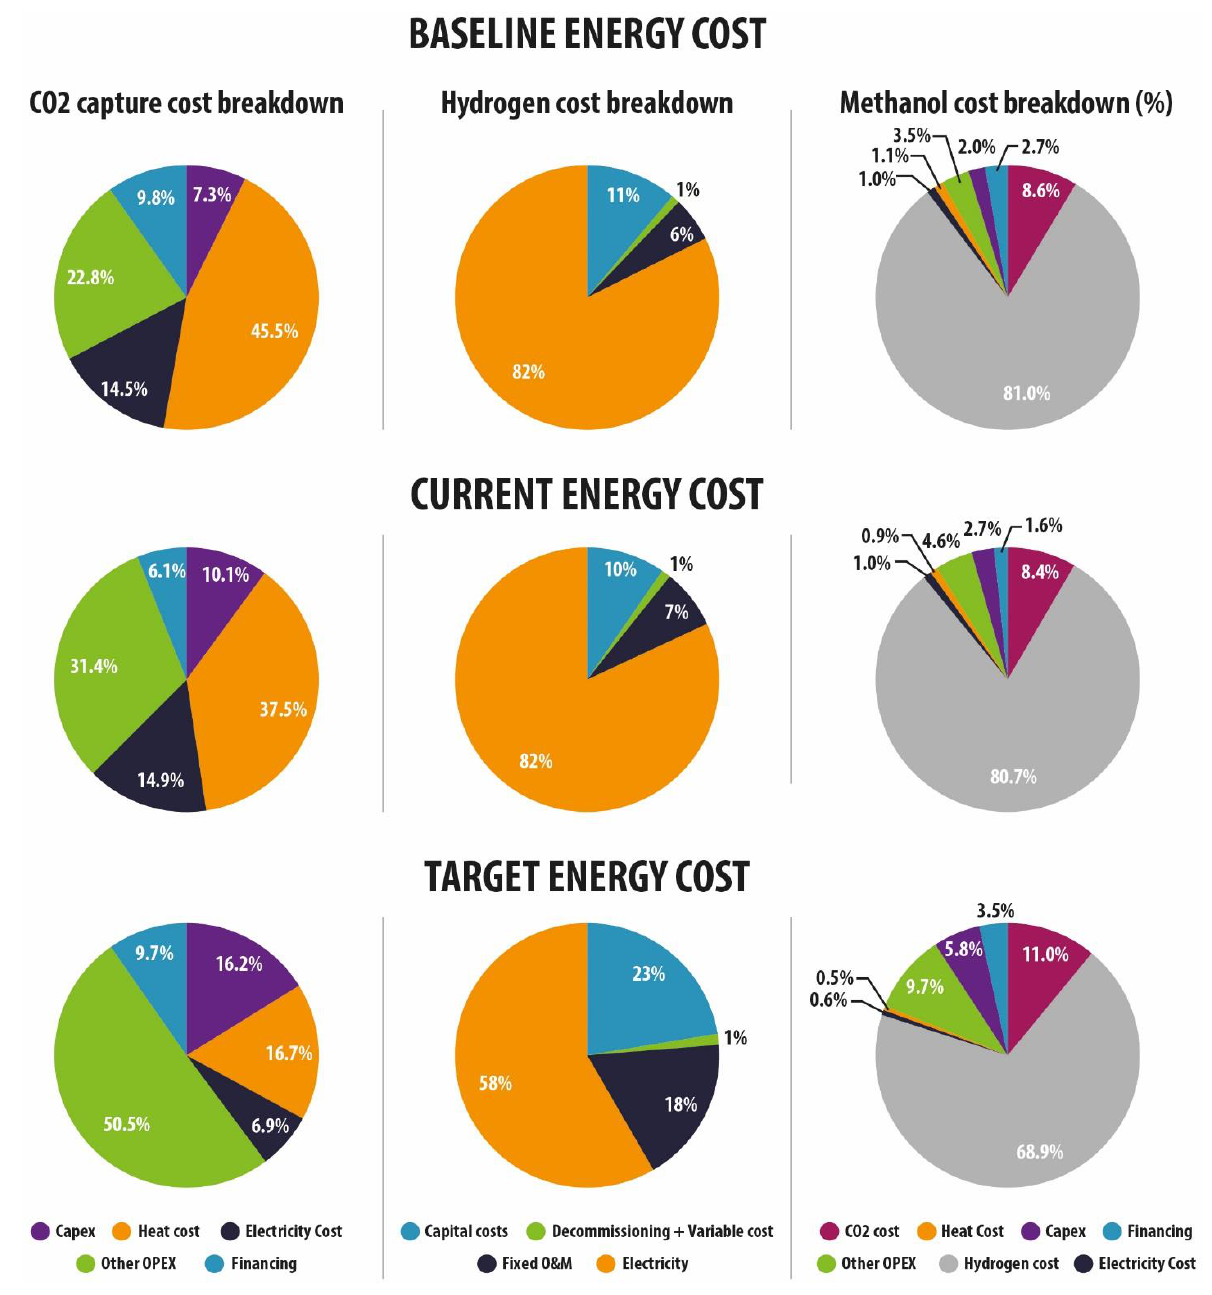
Figure 4. Breakdown of MeOH, CO 2 , and H 2 costs for baseline, current, and near-future target renewable energy costs.